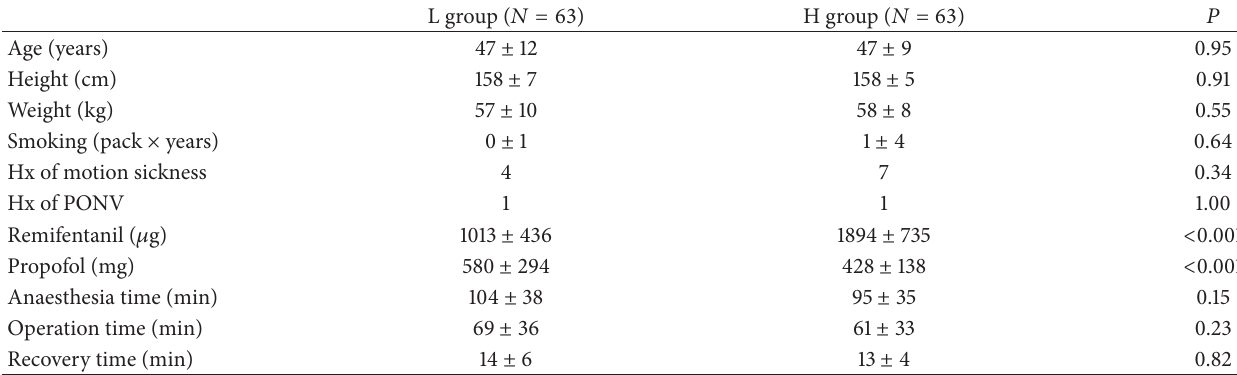
Table 1: Demographic data from the L and H